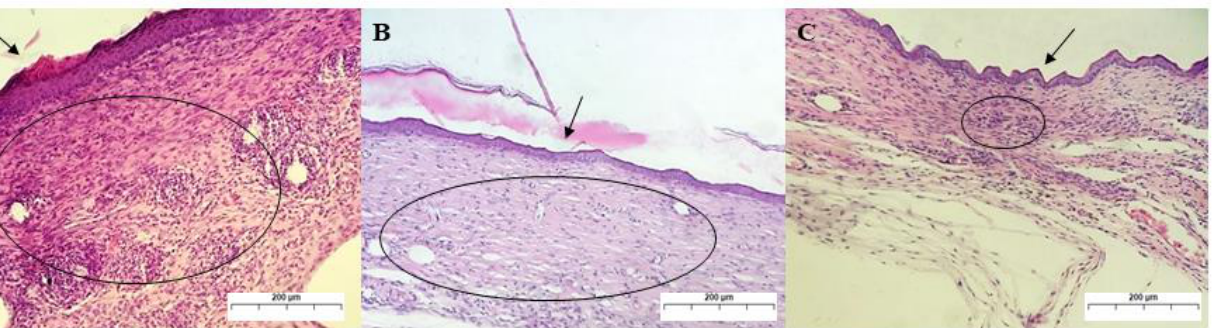
Figure 11. Photomicrograph of skin lesion in mice on the 14th day of treatment. ( A ): Re-epitheliza- tion (arrow) of the wound treated with PS, showing in detail ( A ’ ) granulation tissue in the deep dermis with several newly formed vessels (magnification: 40× and 200×, respectively). ( B ) Re-epi- thelization (arrow) and collagenization (circle) in the dermis for the GChi-treated group, showing in detail ( B ’ ) fibroblast proliferation (asterisks) and mixed inflammatory infiltrate (arrows) (magni- fication: 40× and 100×, respectively). ( C ): Re-epithelization (arrow) of the wound treated with GChiN2, in detail ( C ’ ), collagenization and fibroblasts (circle), and presence of hair follicles and mononuclear infiltrate (arrowhead) (magnification: 40× and 100×, respectively). Staining by H.E. physiological serum (PS), chicha hydrogel (GChi), chicha hydrogel with 0.02 g mL −1 nerolidol (GChiN2).